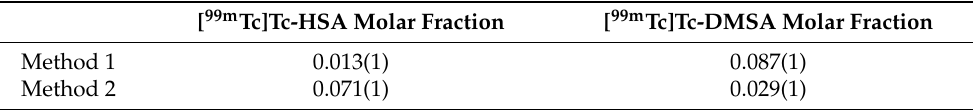
Table 6. Amount of 99m Tc atoms bound to HSA or to DMSA reported as molar fraction (Mean (SD)).